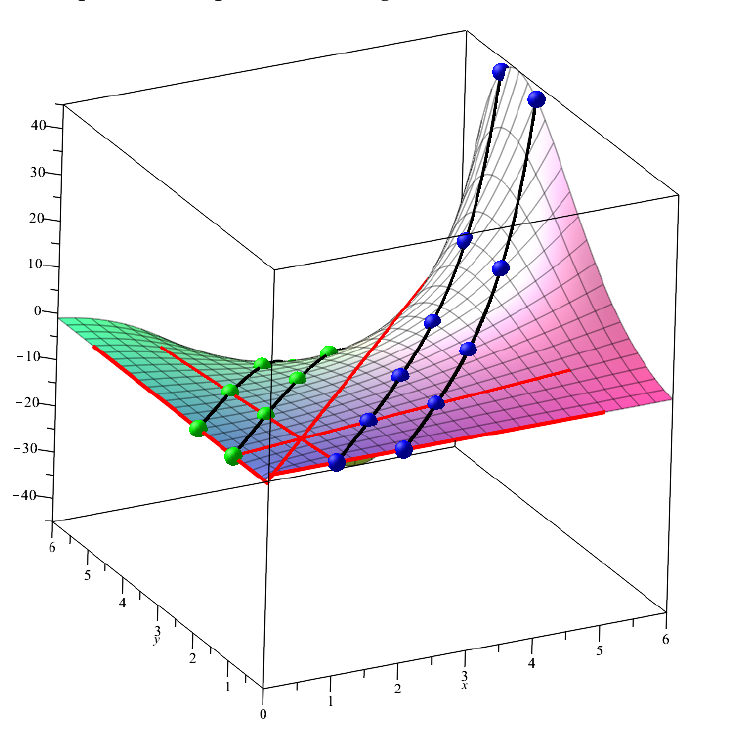
Figure 2. The points corresponding to Catalan numbers C n (the blue ones) and negative Catalan numbers − C n (the green ones); the (red) lines L 1 , . . . , L 5 contained in the surface ( S )